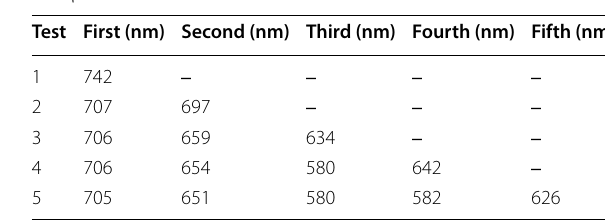
Table 3 Depth variation of each indentation during the one array indentations with the rotation angle of 0° and the